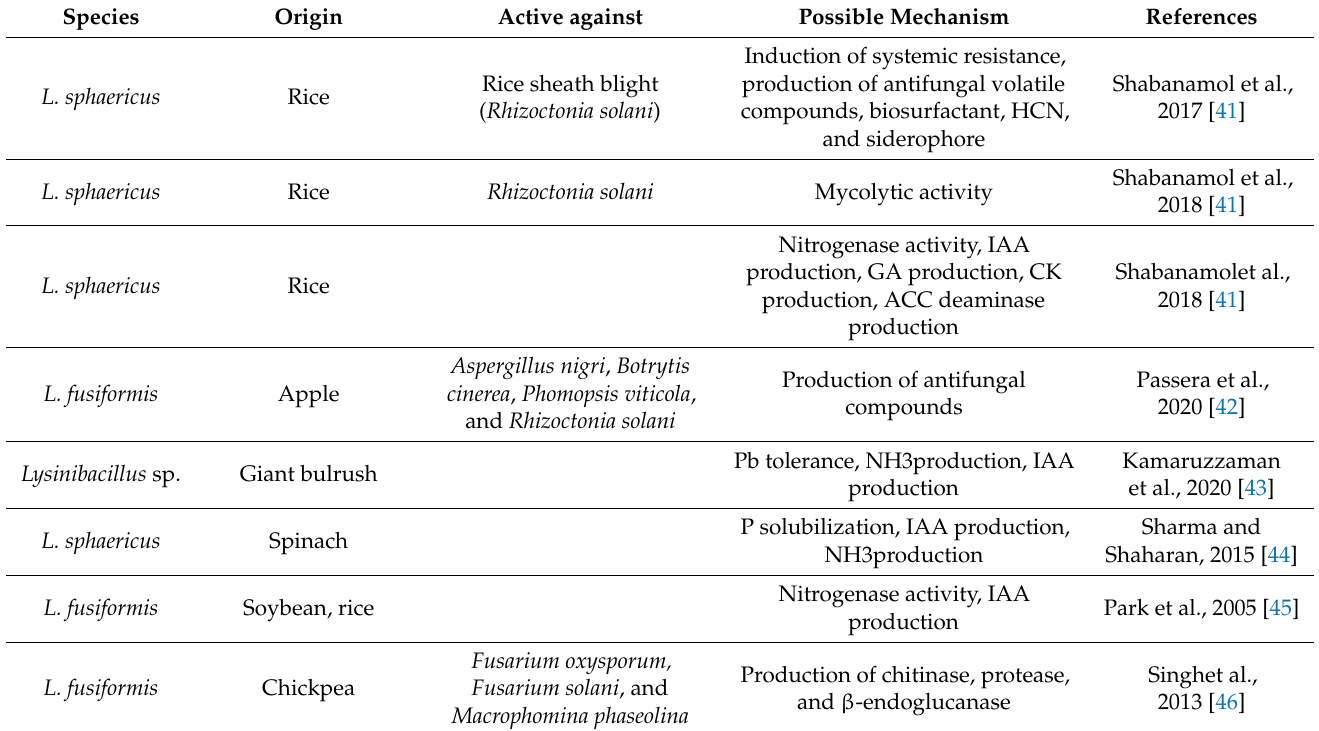
Table 1. Lysinibacillus potentialities and their bioactive